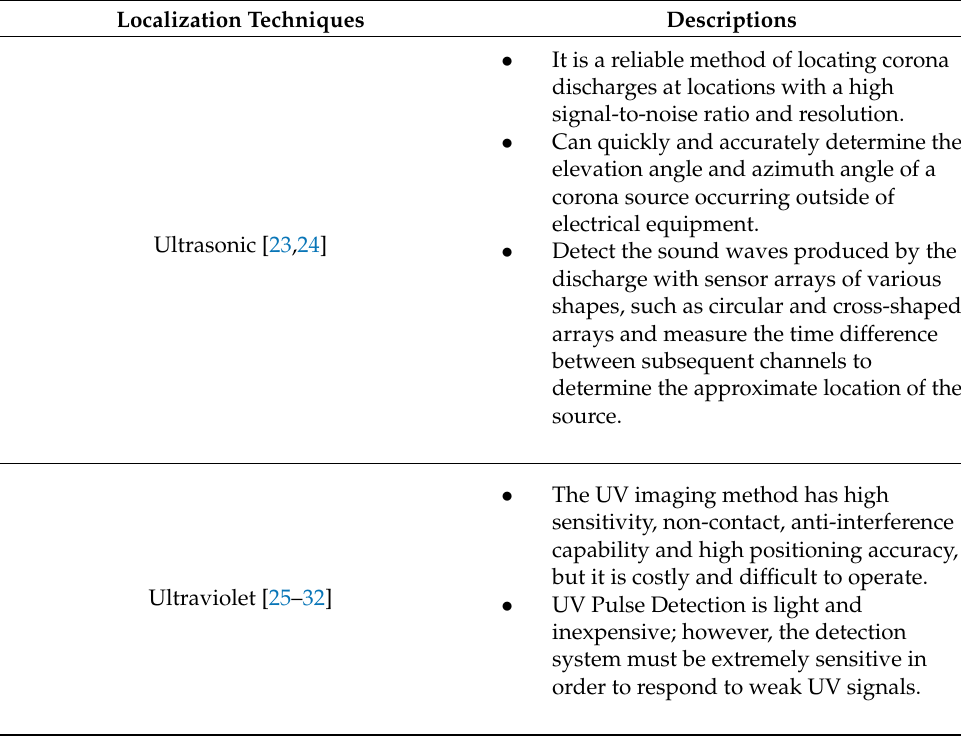
Table 1. Cont. Localization